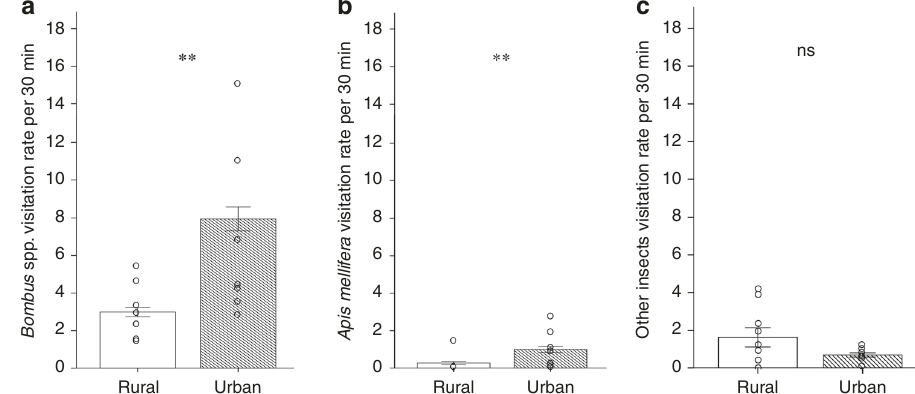
Fig. 5 Trifolium pratense visitation rates in fl ower-rich rural versus paired fl ower-rich urban sites. Flower visitation rates of a all Bombus spp. b Apis mellifera and c all other insects per T. pratense pollinometer plant per 30 min in N = 9 fl ower-rich rural versus N = 9 paired fl ower-rich urban sites; means ± SE are shown; GLMM: ns, not signi fi cant, two stars, P <